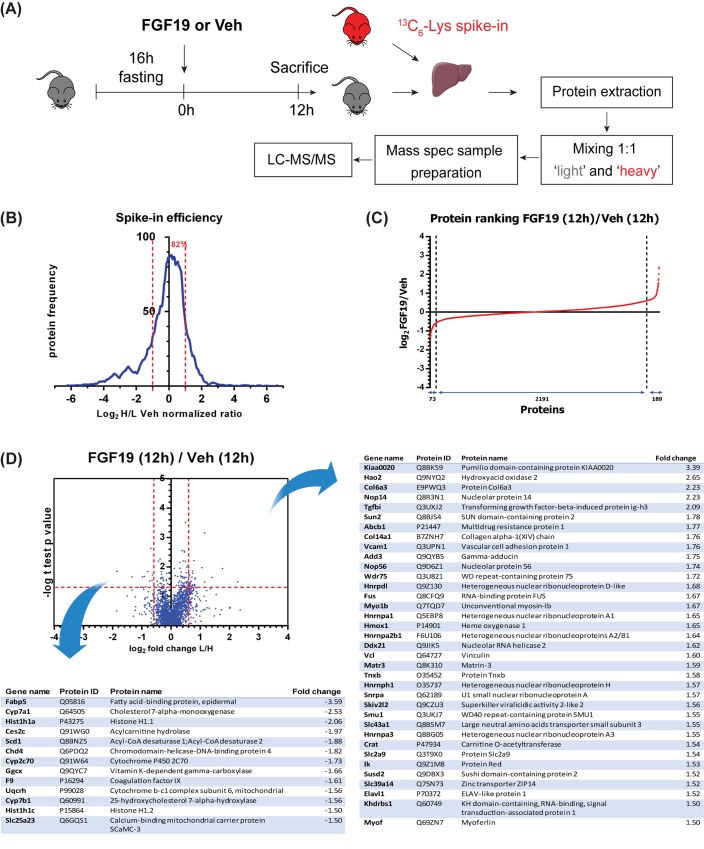
FGF19-mediated regulation of liver protein expression resolved by quantitative proteomics.(A) Schematic representation of the experimental outline to determine the hepatic proteomic profile of mice treated with FGF19 or Veh for 12 h. (n = 3) (B) Frequency plot of proteins identified in vehicle-treated Wt mice based on their total log2 heavy/light normalized ratio. The plot is representative of mean Wt untreated condition to show the basal efficiency of the heavy spike-in added to the light samples. Percentage of proteins with a log2 heavy/light normalized ratio included in interval (-1,+1) is shown. (C) Protein ranking based on changes of the log2 light/heavy normalized ratio induced by FGF19 when comparing FGF19 treatment for 12h to vehicle control. Number of proteins, of which expression was decreased (≤ -1.5 fold), unchanged or increased (≥1.5 fold) are indicated. (C) Volcano plot depicting the protein changes induced by FGF19 after 12h treatment. Plots are accompanied by tables listing the significant upregulated or downregulated proteins with fold change >1.5 (n = 3; p<0.05).